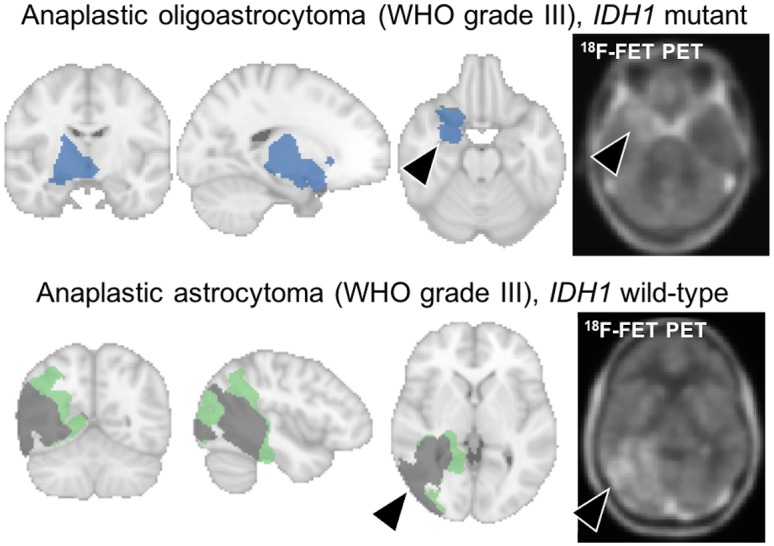
Example of 2 patients with anaplastic oligoastrocytoma IDH1 mutant (patient #22) and anaplastic astrocytoma IDH1 wild-type (patient #24) and their spatial repartition of centroid (blue: Tumor repartition of centroid #1, green: Tumor repartition of centroid #2, grey: Tumor repartition of centroid #3).